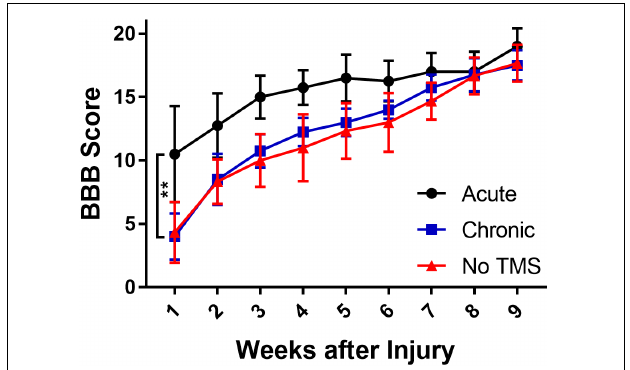
FIGURE 1 | Graph showing effects of TMS treatment on SCI rats assessed by BBB scores over 9 weeks. BBB scores were assessed on a 21-point score (21 being a normal motor function). The scores show that the acute-TMS group ( n = 4) showed significant improvement in scores over chronic ( p = 0.004, n = 4) and no-TMS ( p = 0.0015, n = 3) groups. The chronic-TMS group did not show significant improvement over the no-TMS group. Statistical analysis was performed with one-way ANOVA involving multiple comparisons.